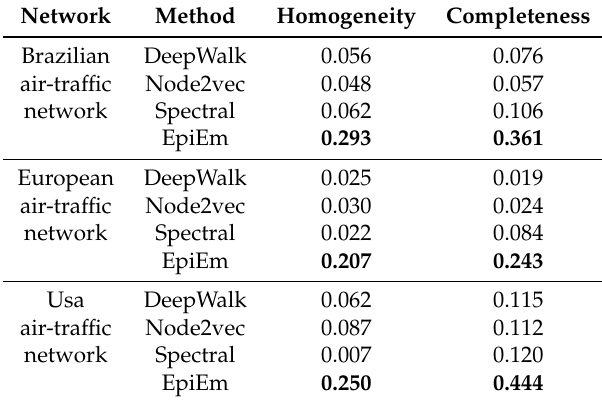
Table 2. Performance of different network embedding methods on three air-traffic networks in terms of homogeneity and